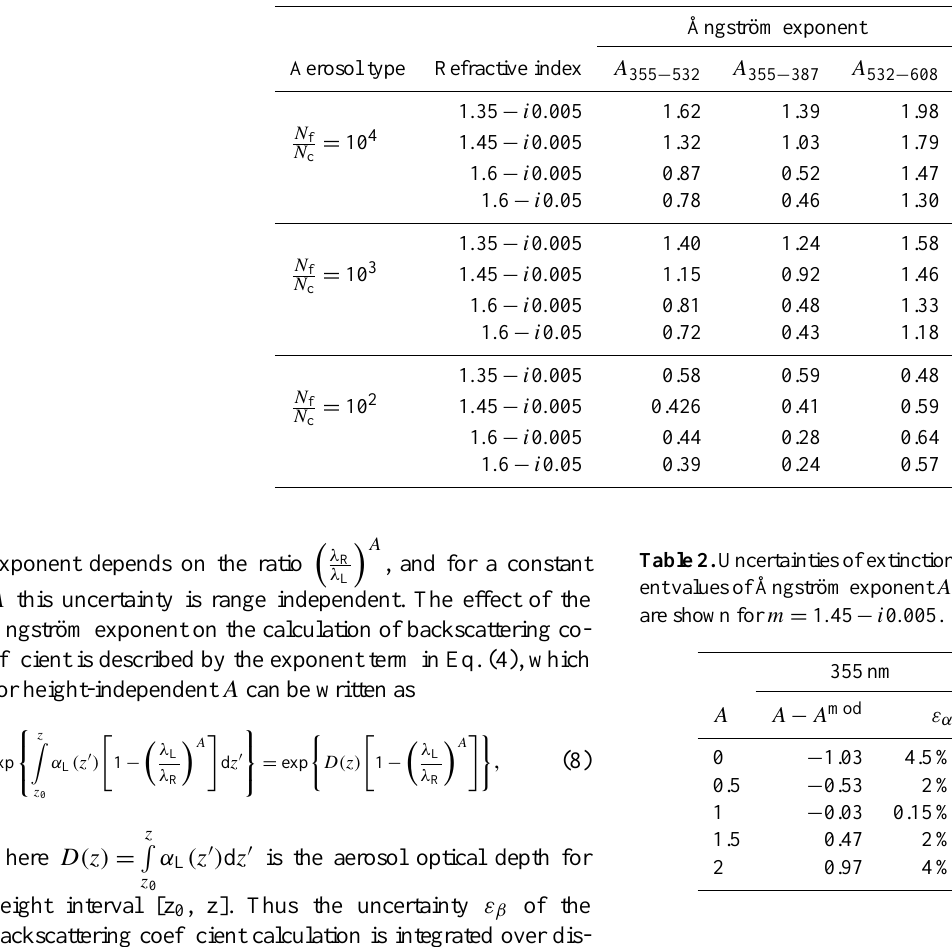
Table 1. Extinction Ångström exponents at 355–532, 355–387, and 532–608nm wavelengths for distributions with different ratios N f different values of refractive index.